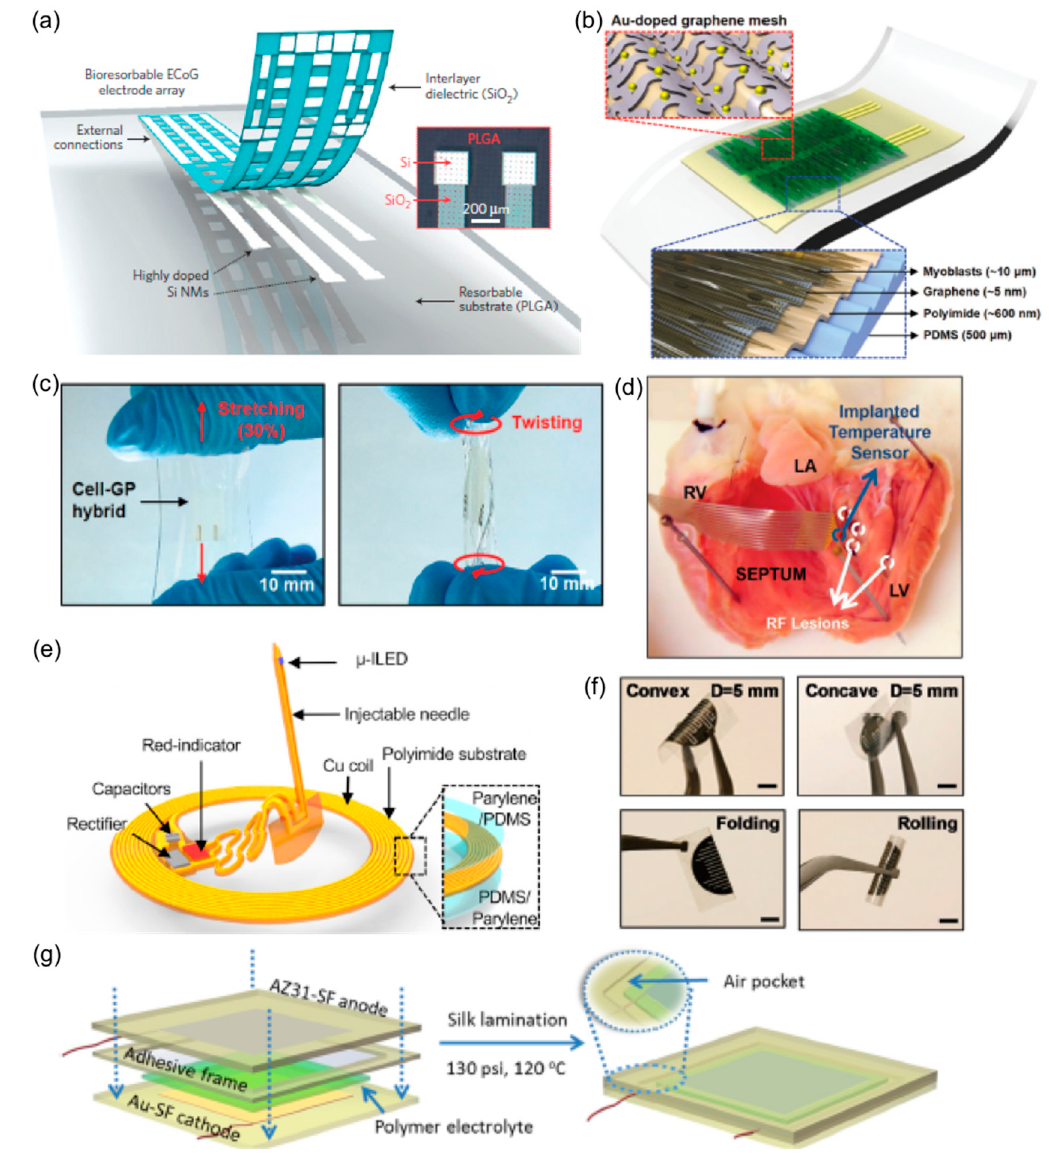
Figure 3. Implantable electronic systems. ( a ) Bioresorbable ECoG electrodes. Reprinted with